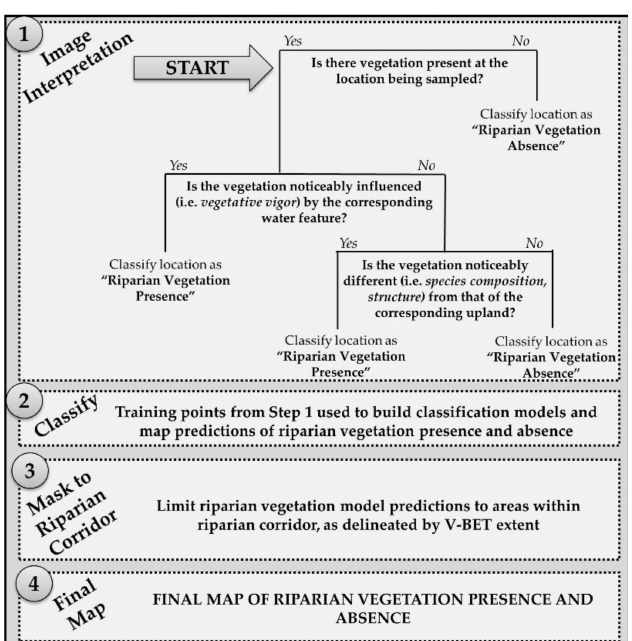
Figure 2. An overview of the process used to delineate riparian vegetation. First, a decision tree process was used by trained image interpreters to evaluate whether a sampled location should be classified as “riparian vegetation presence” or “riparian vegetation absence”. These training points were then used to build classification models of riparian vegetation presence and riparian vegetation absence, and applied as a prediction across each ecoregion. In post-processing, vegetation classified as riparian vegetation that was outside of the valley bottom was then excluded using the valley bottom extraction tool (V-BET) GIS